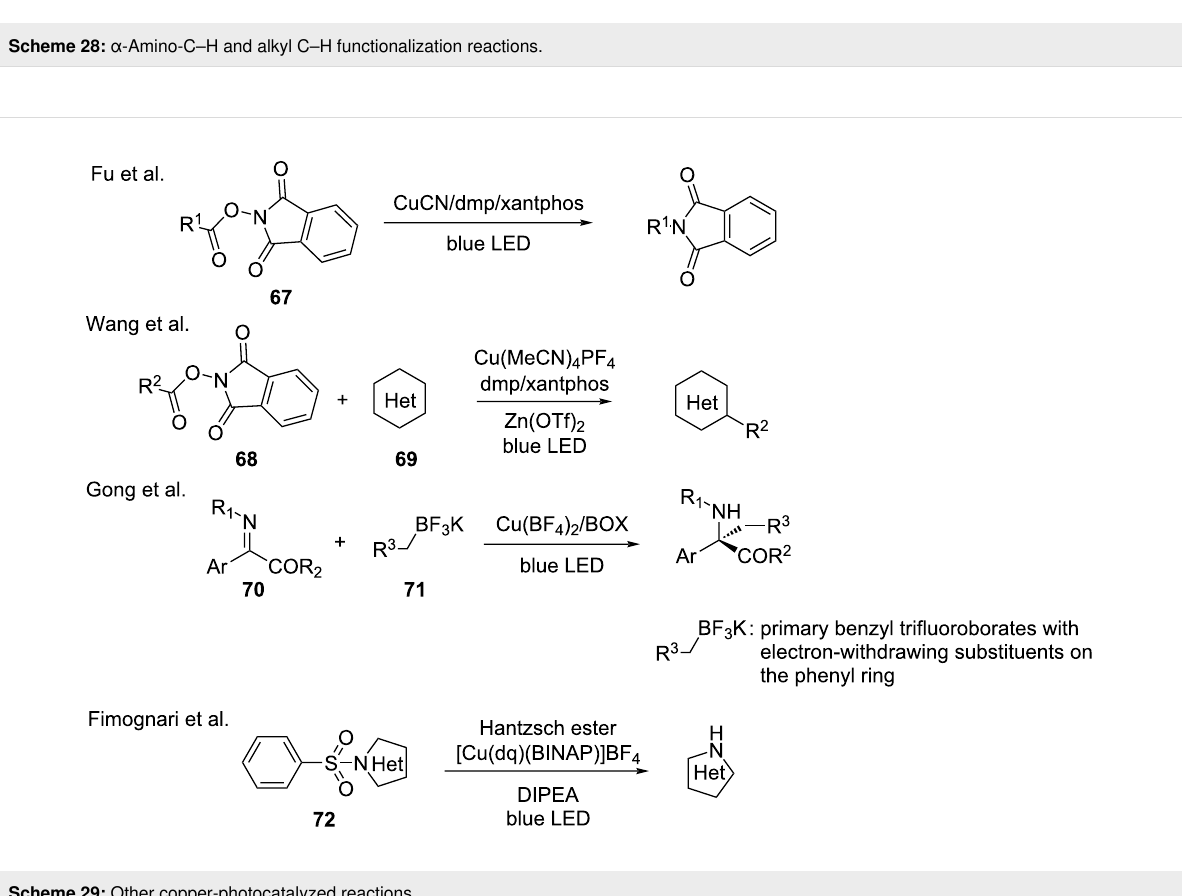
Scheme 29: Other copper-photocatalyzed